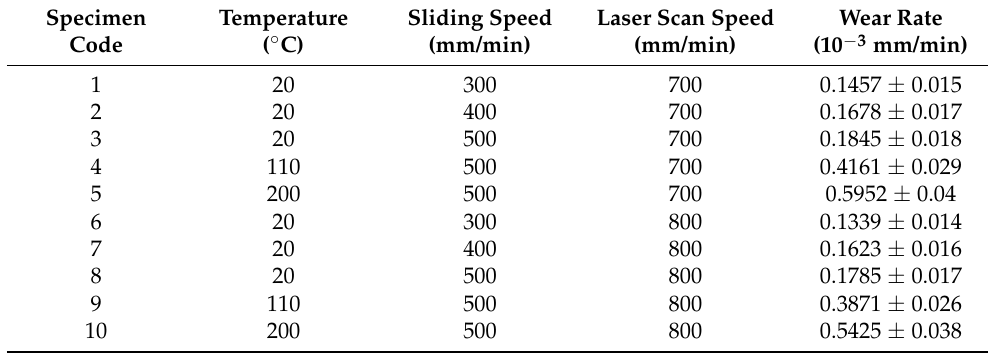
Table 7. Wear rate under lubricated conditions.